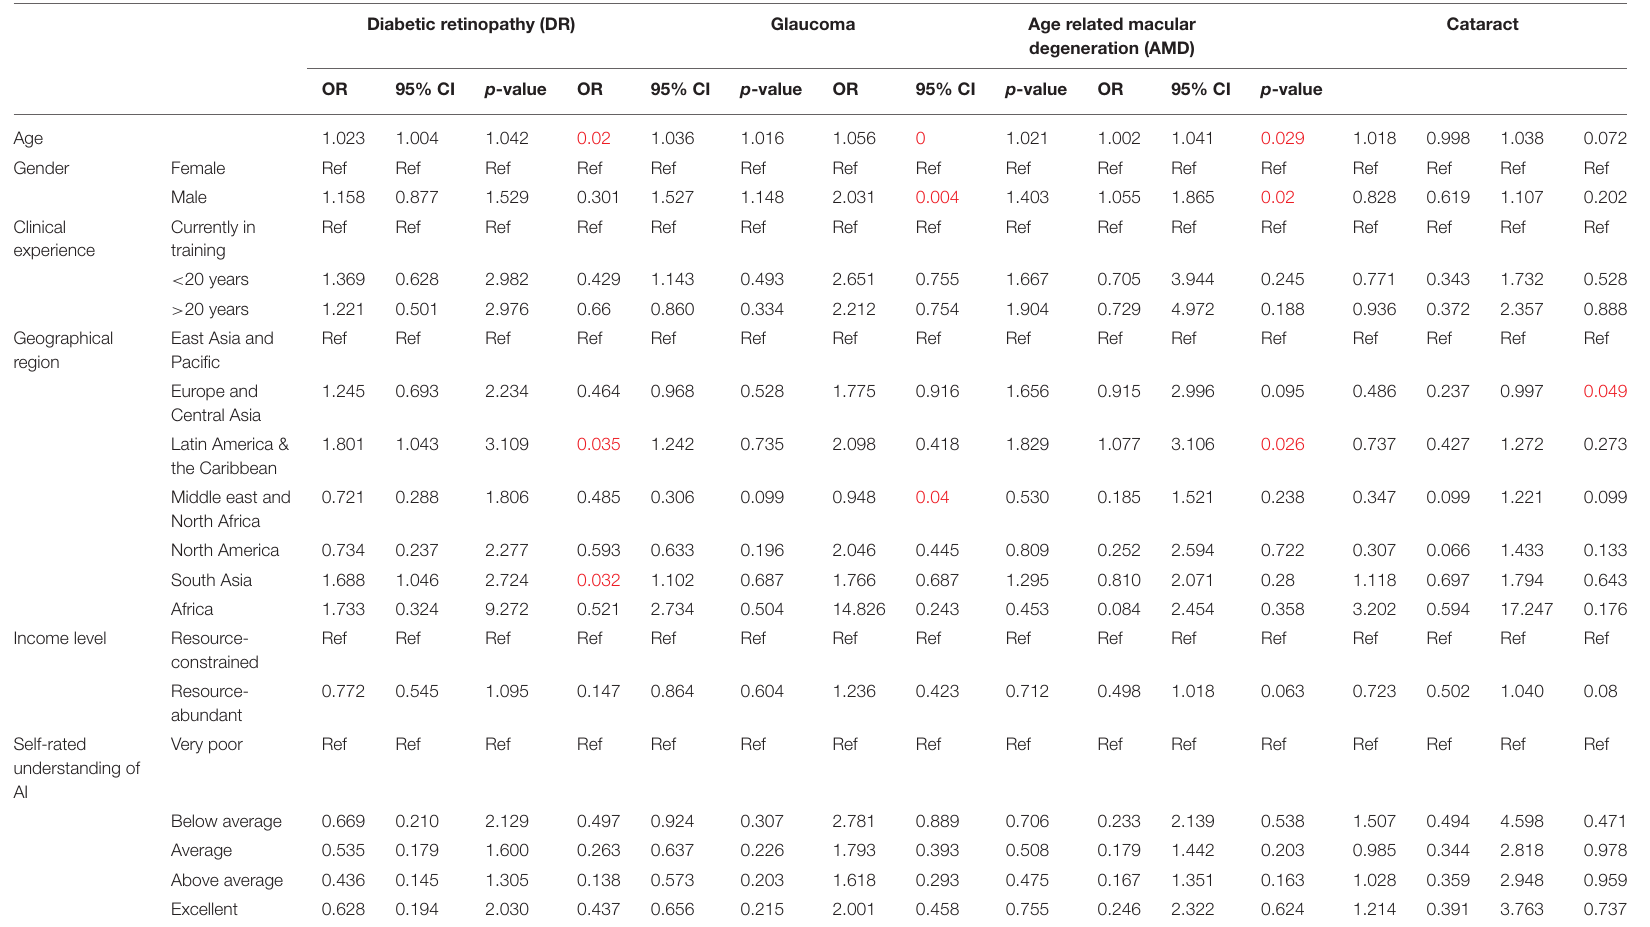
TABLE 3C | Organizational willingness to adopt applications of AI for Diagnosis of eye